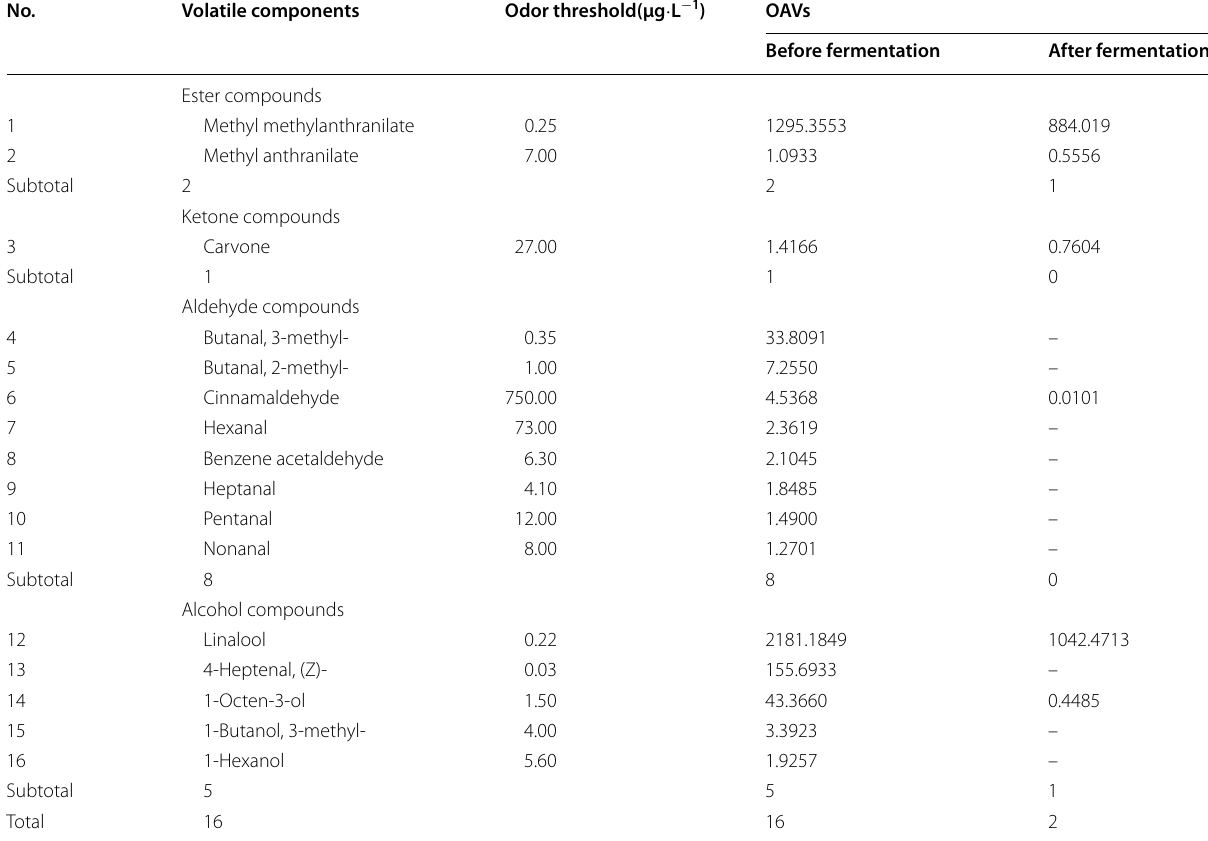
“-” means not detected